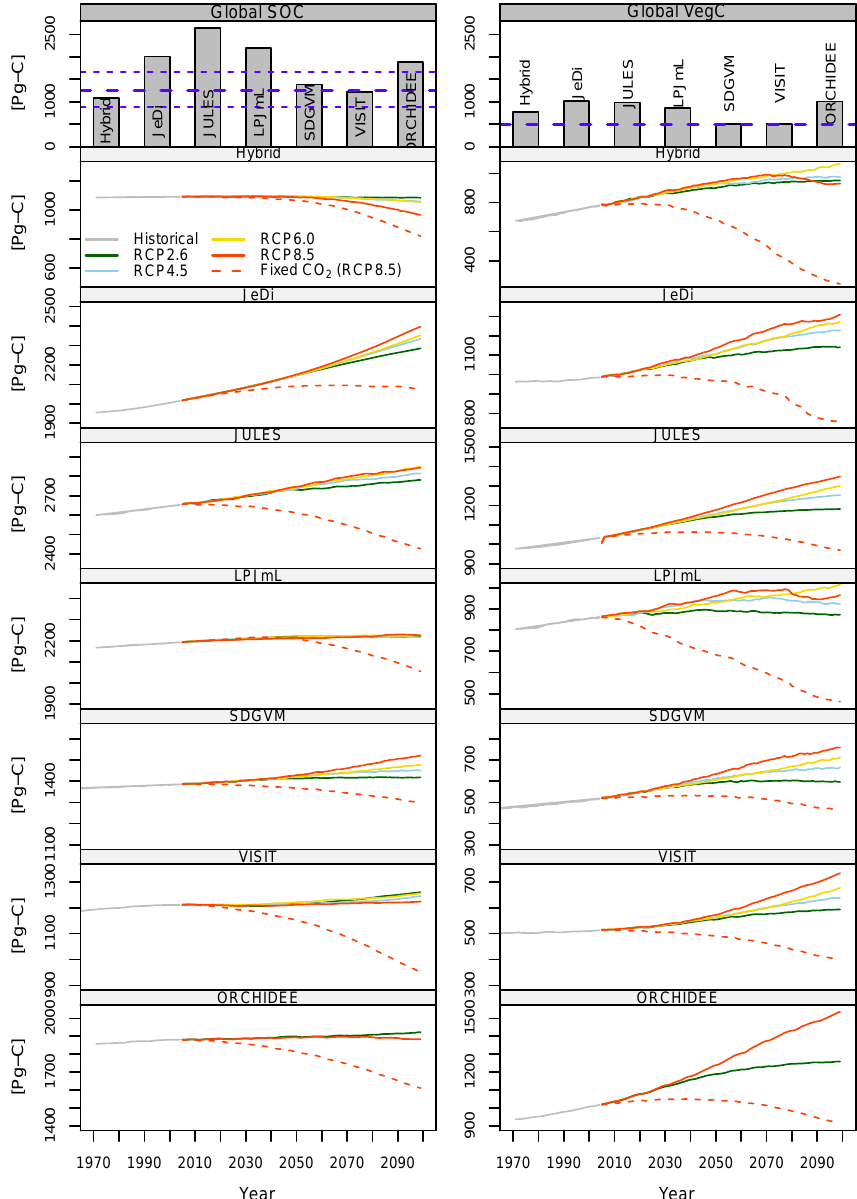
Fig. 2. Changes in global SOC and VegC stocks of each biome model in HadGEM forced by each RCP. Upper bar charts indicate global SOC and VegC stocks in 2000. In the bar chart for global SOC, blue lines indicate the empirical global SOC stock estimated by Todd-Brown et al. (2013) based on the Harmonized World Soil Database (solid line indicates mean and dotted lines indicate 95% confidence intervals). In the bar chart for global VegC, blue lines indicates empirical global VegC stock estimated by Ruesch and Gibbs (2008).